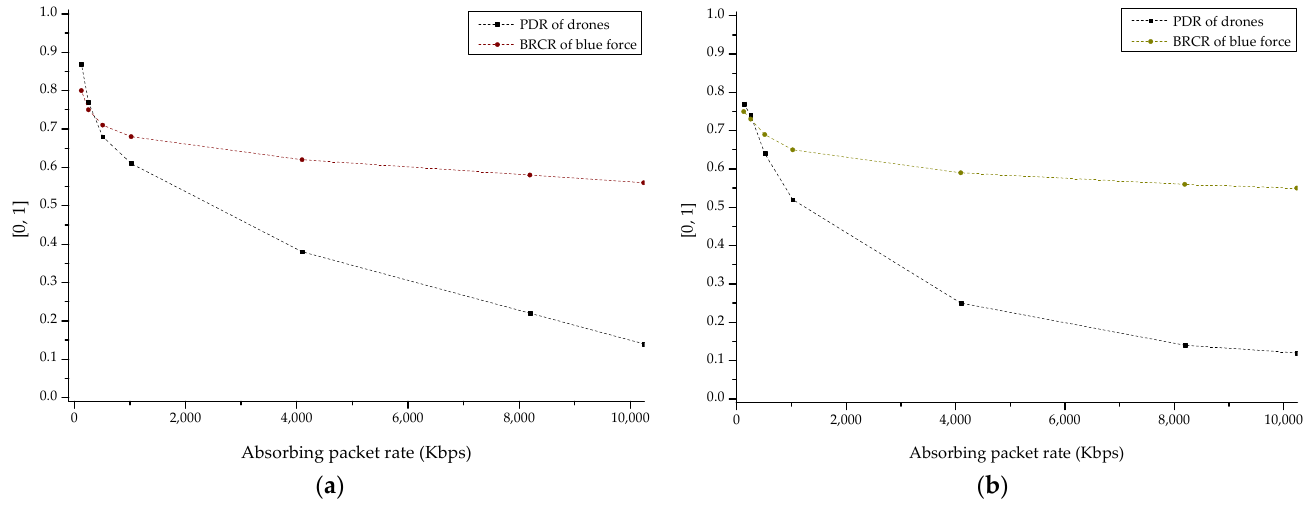
Figure 19. PDR (packet delivery ratio) and BRCR (blue remaining combat ratio) graph by ad hoc based routing attack with absorbing packet rate: ( a ) blackhole attack and ( b ) wormhole attack.